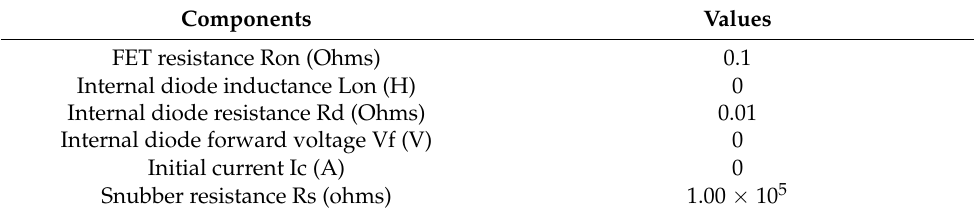
Figure 7. The step response for Equation (31) .